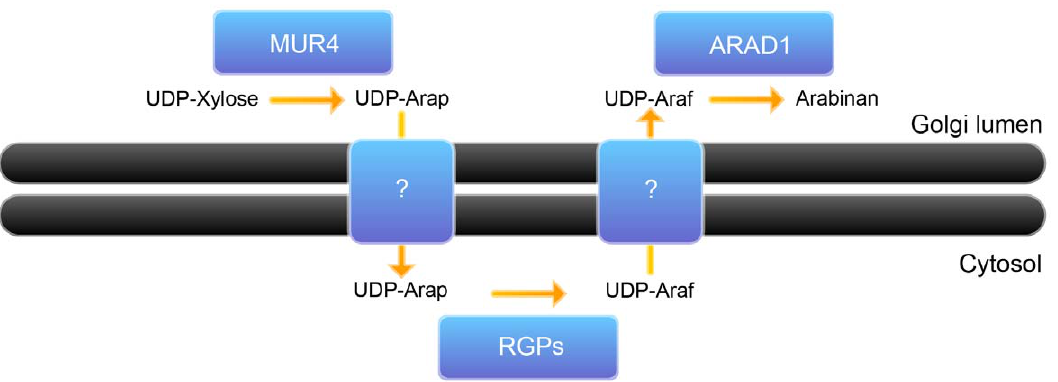
Figure 9. A topology model of Arabinan biosynthesis. UDP-arabinopyranose (UDP-Ara p ) generated by MUR4 in the Golgi lumen is transported to the cytosol possibly by a transporter; UDP-Ara p is converted to UDP-Ara f by RGP1 and RGP2 in the cytosol; UDP-Ara f is transported from the cytosol to the Golgi lumen possibly by a transporter; UDP-Ara f is incorporated into arabinan by glycosyltransferase(s) likely including ARAD1.